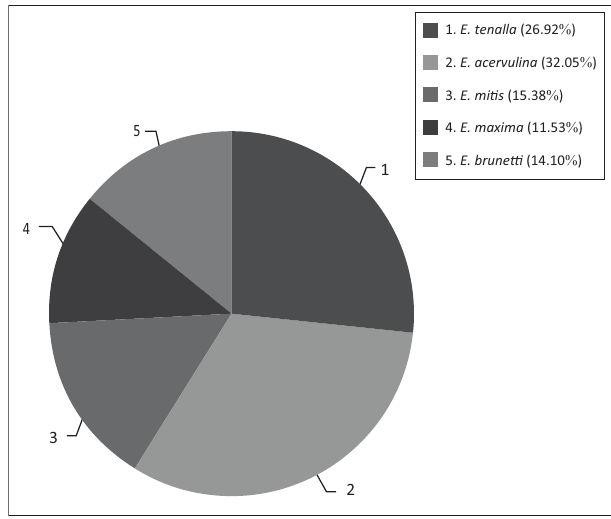
FIGURE 2: Prevalence of various Eimeria spp. at broiler chicken farms in the Bejaia area.